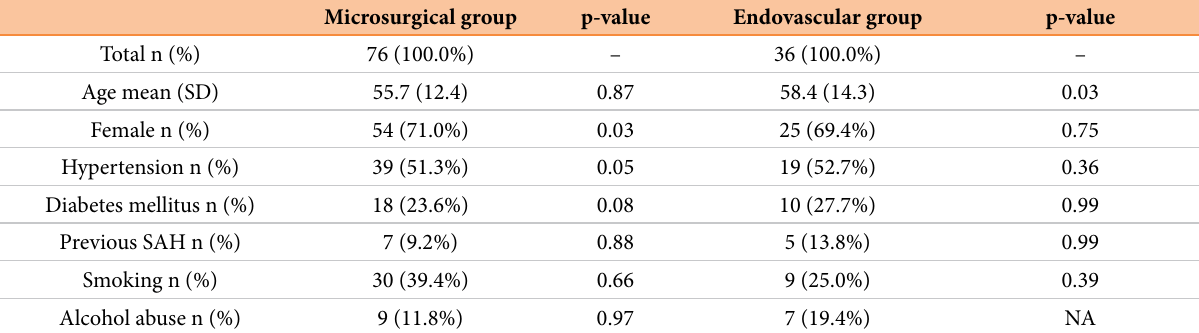
Table 2 - Demographic characteristics and its respective association with death at